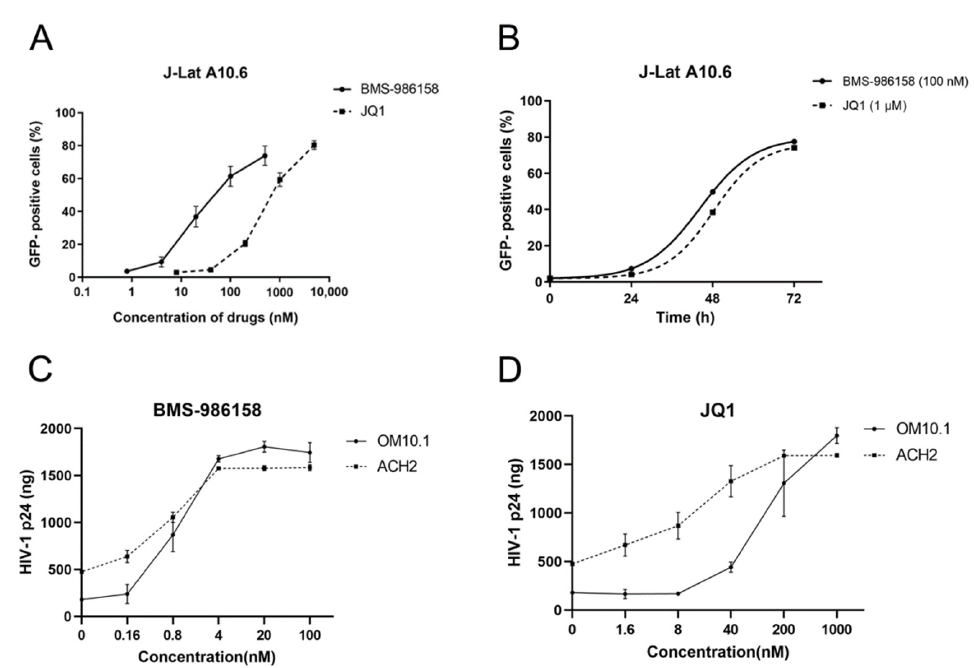
Figure 1. Reactivation activity of BMS-986158. ( A ) J-Lat cells were treated with gradient-diluted BMS-986158 and JQ1 for 48 h and percentage of GFP-positive cells was measured by flow cytometry. ( B ) J-Lat cells were treated with BMS-986158 and JQ1 for different times (0, 24, 48, and 72 h) and percentage of GFP-positive cells was measured. ( C , D ) OM10.1 and ACH2 cells were treated with double-diluted BMS-986158 or JQ1 for 48 h and quantity of HIV-1 p24 in cell culture supernatant was measured by ELISA. All data represent the mean ± SD of three independent experiments. To confirm the reactivation ability of BMS ‐ 986158, we tested the effects of BMS ‐ 986158 on cell associated (CA) HIV ‐ 1 RNA in PBMCs isolated from HIV ‐ 1 ‐ infected indi ‐ viduals receiving long ‐ term ART. After treatment with BMS ‐ 986158 or JQ1 for 24 h, the expression of CA HIV ‐ 1 RNA increased in 12 (BMS986158) and 11 (JQ1) of the 20 individ ‐ uals, respectively (Table 1), indicating that BMS ‐ 986158 reactivated latent HIV ‐ 1 during ART ex vivo. Table 1. The effect of BMS ‐ 986158 on the expression of cell associated (CA) HIV ‐ 1 RNA. Donors